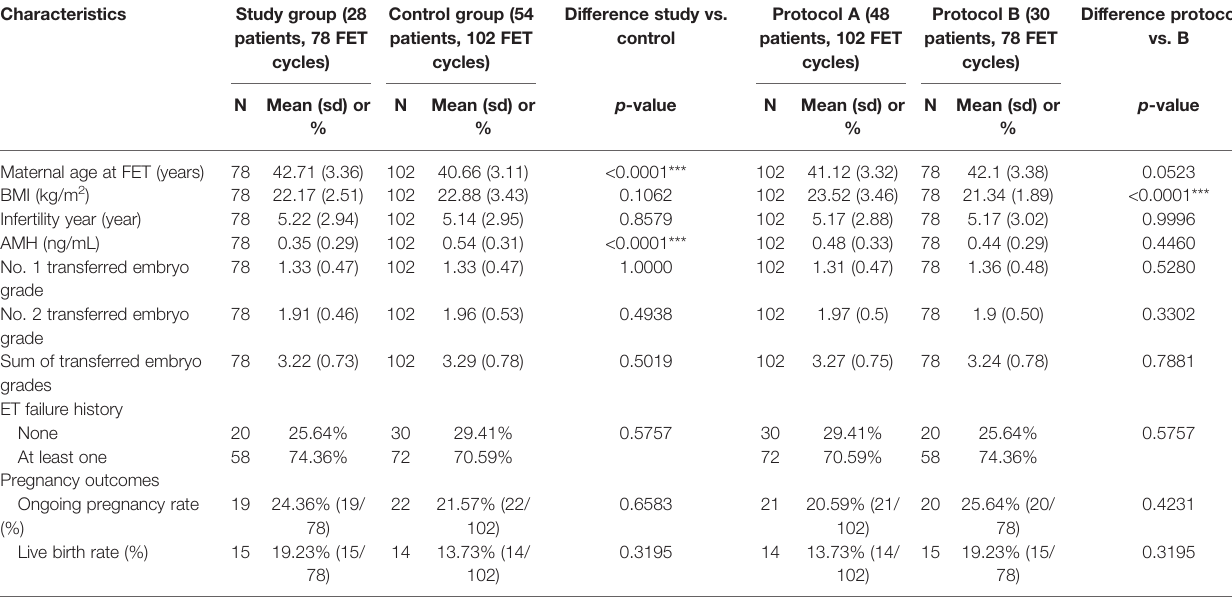
TABLE 2 | Patient characteristics strati fi ed by treatment protocol among patients receiving embryo transfer cycles.